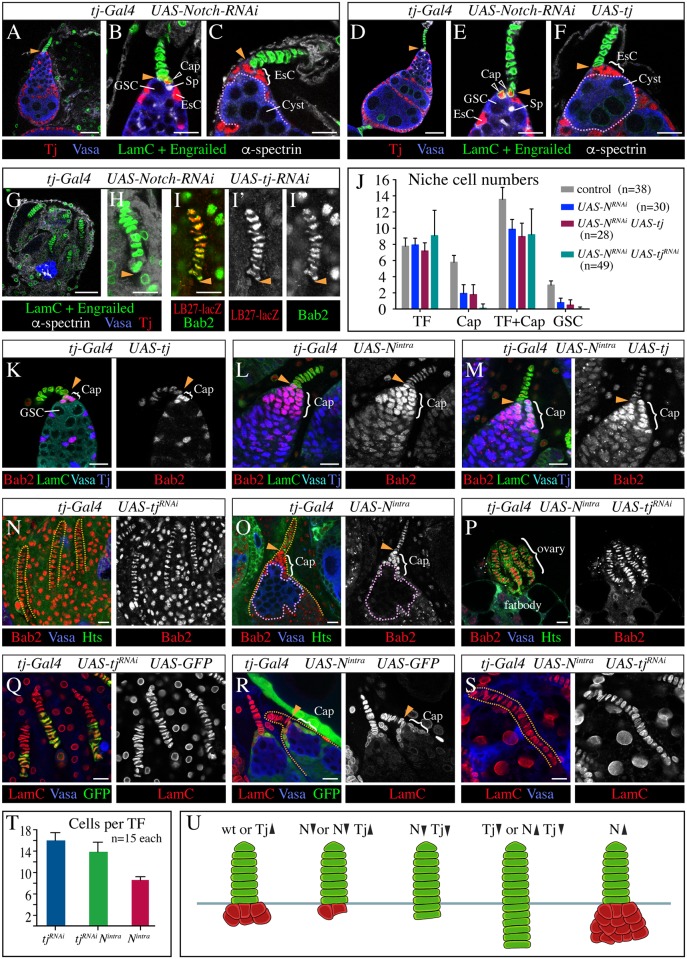
Tj and N have different effects on cap cell development.A yellow arrowhead marks the posterior end of the TF. (A-J) The effects on cap cells caused by N depletion and altered Tj expression. (A-C) N knockdown by RNA interference (RNAi) causes a reduction of cap cells. (A) Fusion of germarium and follicles is typical of a N loss-of-function phenotype. (B) This germarium has only two cap cells (one visible) and one GSC. Note that the cap cell (open arrowhead) expresses Tj, is round and not aligned with the TF. (C) Absence of cap cells is accompanied by a lack of GSCs. A differentiating germline cyst (stippled outline) is located at the tip of the germarium adjacent to ectopically located escort cells (EsC). (D-F) N depletion in combination with Tj overexpression causes a phenotype similar to N knockdown alone: compare panel D with A, E with B, and F with C. (G-I‴) Ovaries with N tj double-knockdown show a combination of N and tj loss-of-function characteristics: all anterior niche cells display the TF fate but their number is reduced. (G) The ovary contains only TFs, surrounded by ovariole sheaths, and a small germline cluster. (H-I‴) All cells in the elongated TFs display the shape and markers of TF cells. (J) The graph compares the number of different cells in the GSC niche of ovaries that have reduced N expression combined with endogenous, reduced or increased levels of Tj expression. UAS-constructs were driven by tj-Gal4, and w flies served as a control. Mean + s.d. are indicated. n, sample size. (K-T) The effects of altered Tj expression in ovaries that express constitutively active N (Nintra) in a tj-specific pattern. In contrast to a tj overexpressing ovariole that has a normal-sized niche (K), germaria that expressed Nintra either alone (L) or in combination with transgenic Tj (M) display a massively increased pool of cap cells, as highlighted by strong expression of Bab2, but lack Vasa-positive germ cells. (N) A Tj-depleted ovary with abnormally long TFs (yellow stippled lines). Cap cells are absent. Sheath cells fill the space between the elongated TFs. (O) A Nintra expressing ovariole with a normally looking TF and an increased number of cap cells that contact a cluster of GSC-like cells (pink stippled line). (P) A rudimentary ovary, caused by depletion of Tj and expression of Nintra that only consists of a group of abnormally elongated TFs attached to fatbody. Cap cells and sheath cells are absent. (Q) Abnormally elongated TFs in an ovary that co-expresses tjRNAi and GFP. The GFP-positive TF cells represent transformed cap cells. (R) In Nintra GFP co-expressing ovarioles, GFP is seen in cap cells but not in TFs. LamC staining in cap cells is visibly weaker than in TF cells. (S) A very long TF surrounded by fatbody cells in an ovary that co-expresses tjRNAi and Nintra. Strong staining of LamC is seen throughout the TF. (T) The graph compares the number of cells per TF between the indicated genotypes. Mean + s.d. are indicated. n, sample size. (U) Schematic drawing illustrates the niche defects resulting from altered Tj and N expression. Anterior is up in all images. Scale bars: 25 μm in A,D,G, and 10 μm in all other images.